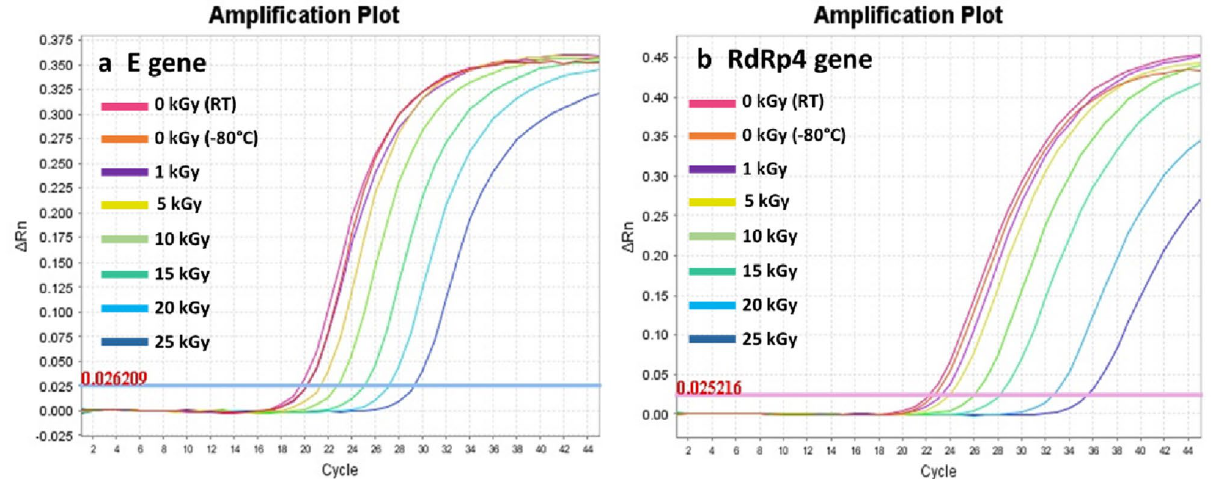
Figure 6. Representative images of RT-qPCR results of SARS-CoV-2 RNA E ( a ) and RdRp4 ( b ) genes detection following different gamma irradiation doses ranging from 1 to 25